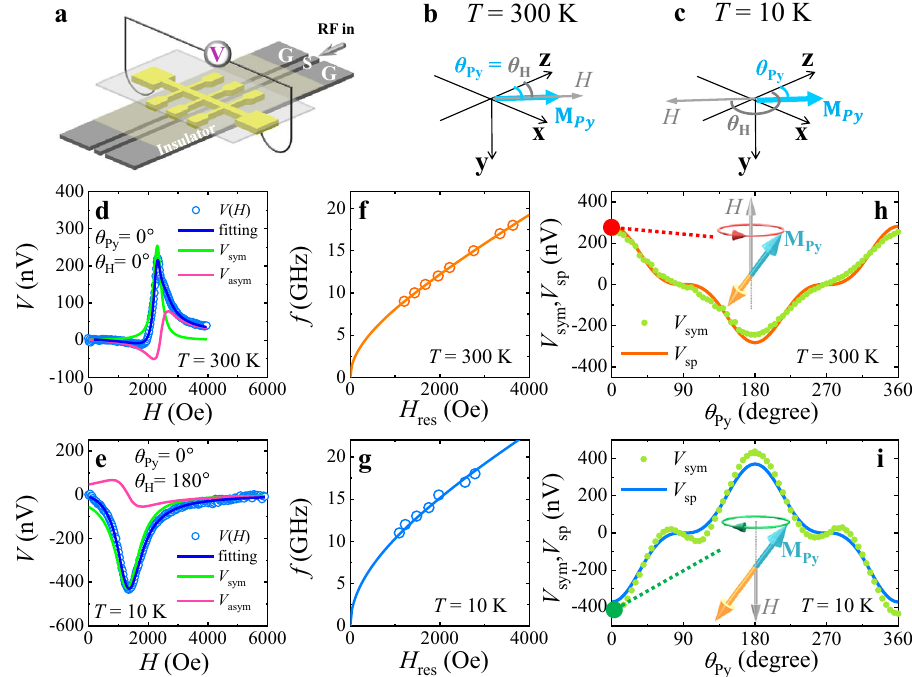
Fig. 3 Chirality-dependent spin pumping versus spin recti fi cation effect in the FMR mode. a Illustration of spin pumping measurements. The experimental geometry is characterized by the azimuthal directions of H ( θ H ) and M Py equilibrium ( θ Py ). b M Py is parallel to H at T = 300 K. c M Py is antiparallel to H at T = 10 K. V ( H ) signals ( f = 13 GHz) are plotted with the fi tting curves for d θ Py = 0° and θ H = 0° at T = 300 K and e θ Py = 0° and = 180° at T = 10 K. V fi cation effect. The H f θ H asym of opposite polarities (magenta lines in d , e ) are ascribed to the spin recti res dependences of frequency ( f ) at T = 300 K and ( g ) at T = 10 K are effectively described by the Kittel equation, con fi rming the perfectly antiparallel alignment of M Py and M Gd in FMR. θ V V T = 300 K and ( i ) T = 10 K. A positive V θ = 0° Py -dependent sym and sp are plotted at ( h ) sp was produced by the right-handed M Py precessions ( Py and θ H = 0°, marked by the red dot in h ). The negative V sp is produced by the left-handed M Py precession ( θ Py = 0° and θ H = 180°, marked by the green dot in i multilayer 29 . M Py and M Gd are perfectly antiparallel to each other during the precessions, leading to the right-handed M Py precession at T = 300 K and the left-handed M Py precession at T = 10 K. The right-handed (left-handed) M Py precession pro- duces the positive (negative) V ( H ). Note that the microwave fi eld